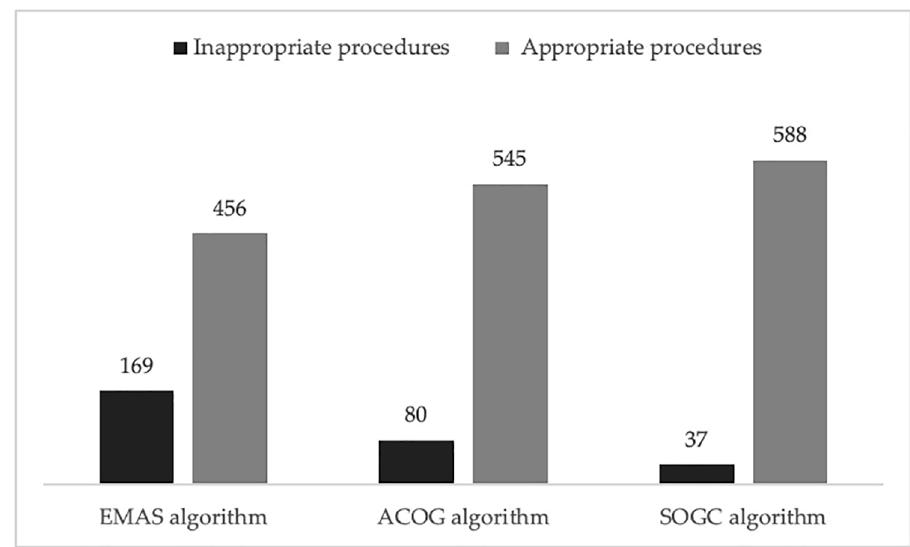
Figure 2. Comparison between different algorithms. The bar chart shows the different number of appropriate and inappropriate hysteroscopies according the three different algorithms considered.